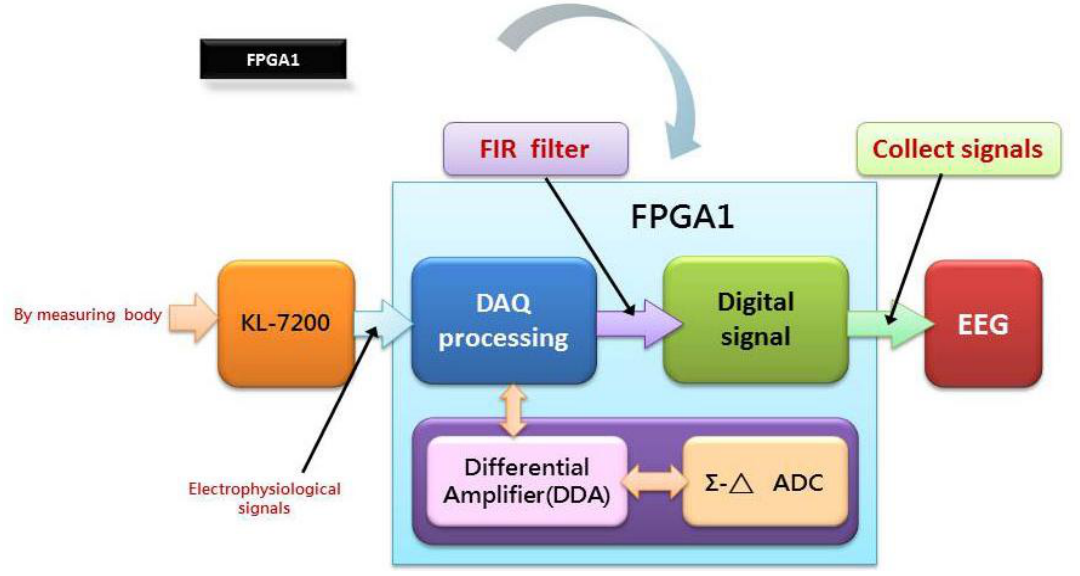
Figure 4. An embedded chip, FPGA1, design approach.